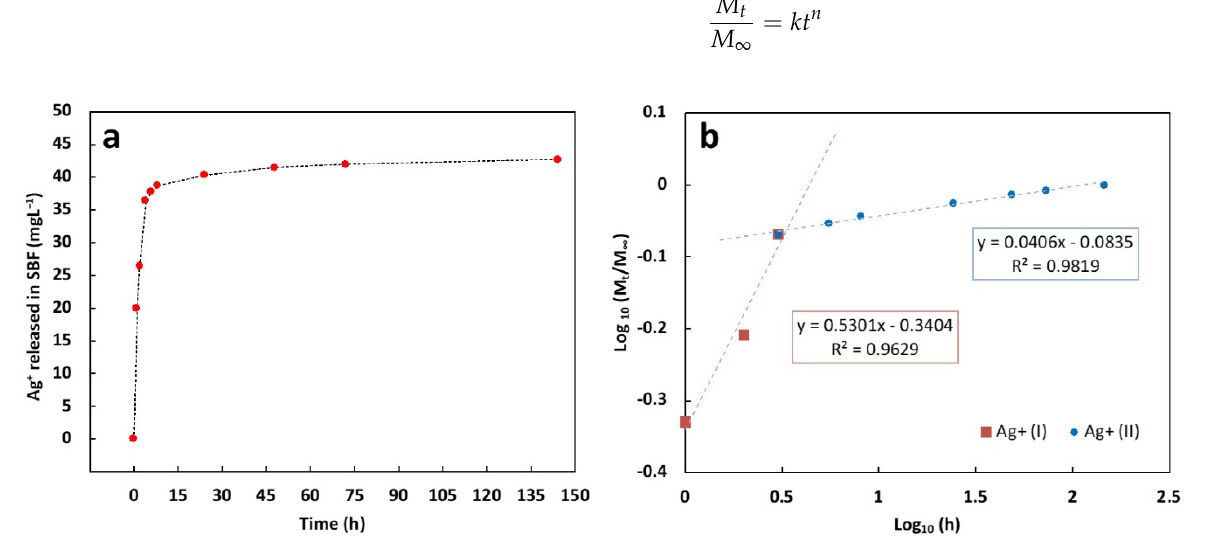
Figure 8. ( a ) Ag + cumulative release curve from composite coating in SBF at 37 °C; ( b ) Log (M t /M ∞ ) vs. Log (time) curves of the two release stages and their corresponding regression equations.